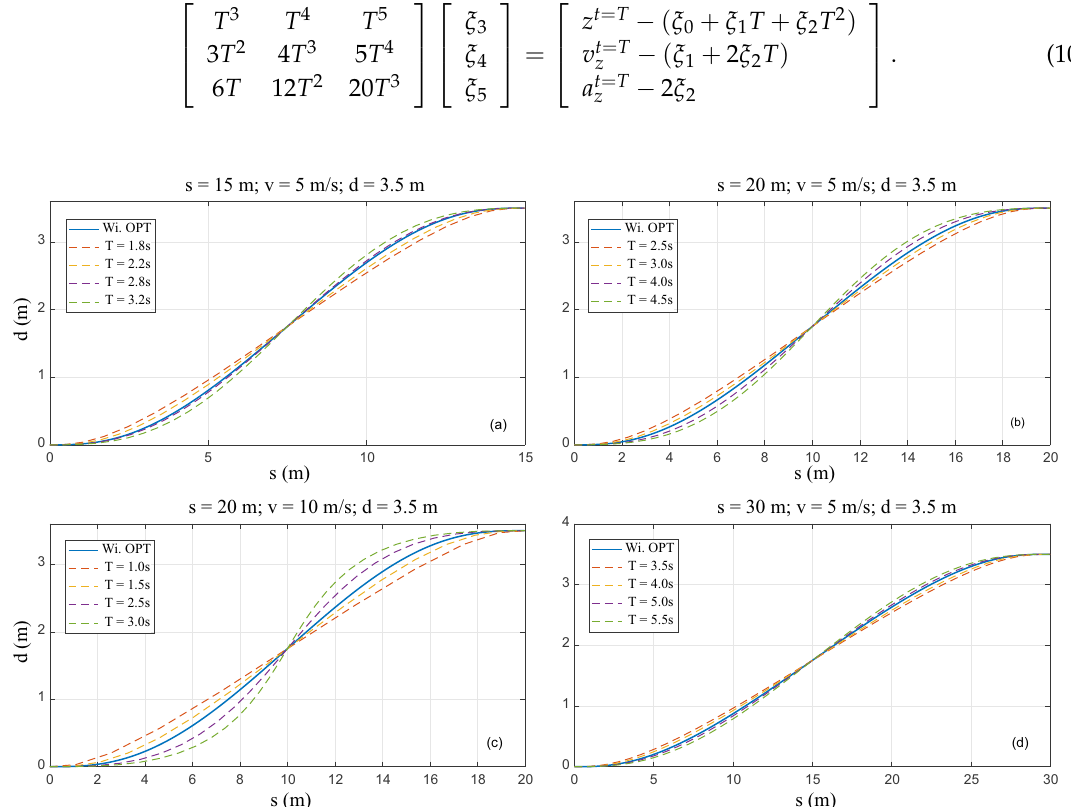
Figure 4. Optimization solving based-jerk minimization problem, ( a ) s = 15 m; v = 5 m/s; d = 3.5 m; ( b ) s = 20 m; v = 5m/s; d = 3.5 m; ( c ) s = 20 m; v = 10 m/s; d = 3.5 m; ( d ) s = 30 m; v = 5 m/s; d = 3.5